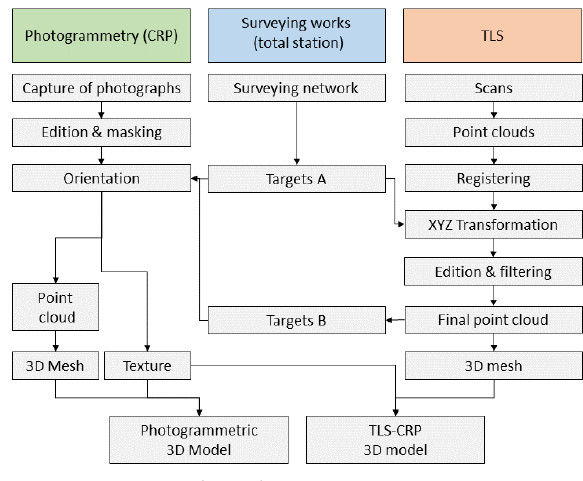
Figure 3. Methodology.